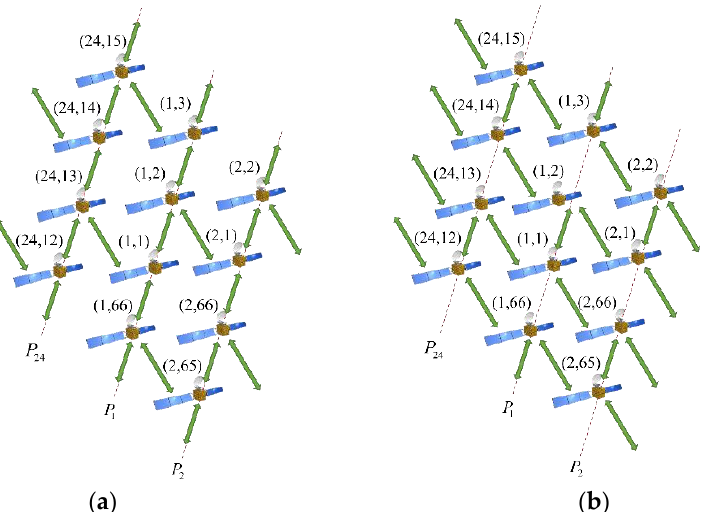
Figure 2. Schematic diagram of two types of combination methods for fixed links. ( a ) One AOPL and two intra-OP links; ( b ) two AOPLs and one intra-OP link.